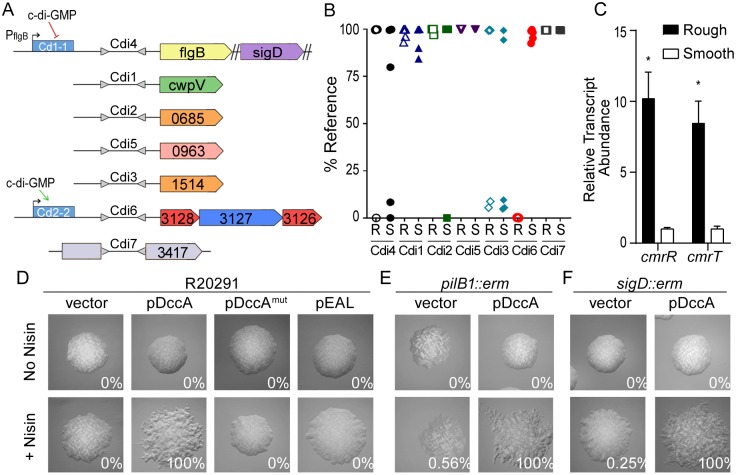
Expression of a c-di-GMP regulated phosphorelay system promotes rough colony formation in a TFP- and flagellum-independent manner.(A) Diagram of seven invertible DNA elements previously identified in C. difficile R20291. Gray triangles represent inverted repeats flanking invertible elements, which are named according to previously defined nomenclature [29]. Downstream regulated genes are shown. Blue rectangles denote c-di-GMP riboswitches, and direction of regulation is indicated with arrows. (B) qPCR analysis of the orientations of the seven invertible DNA sequences in rough (R) and smooth (S) colony isolates. Data are expressed as the percentage of the population with the sequence in the orientation present in the reference genome (FN545816). Symbols indicate values from individual isolates. (C) qRT-PCR analysis for expression of cmrR and cmrT in rough and smooth isolates grown on BHIS agar. Data from four biological replicates was analyzed using the ΔΔCt method with rpoC as the reference gene and was normalized to the smooth condition. Shown are means with standard deviations. *p < 0.0001, Holm-Sidak multiple t test. (D-F) C. difficile R20291, a TFP-null (pilB1) mutant, and an aflagellate (sigD) mutant containing the indicated plasmids for manipulation of intracellular c-di-GMP were grown on BHIS agar with or without inducer (2 μg/mL nisin). Shown are images representative of the most common morphology yielded by each strain. Values in each panel indicate the percentage of rough colonies of ≥100 total colonies from at least two independent experiments. All images were taken at ×2 magnification. Data can be found in supplemental file S1 Data. BHIS, brain heart infusion plus yeast; c-di-GMP, cyclic diguanosine monophosphate; cmr, colony morphology regulators; DccA, diguanylate cyclase A; erm, erythromycin resistance cassette; mut, mutant; R, rough; S, smooth; qPCR, quantitative PCR; qRT-PCR, quantitative real-time PCR; sigD, sigma factor D gene; TFP, type IV pilus.